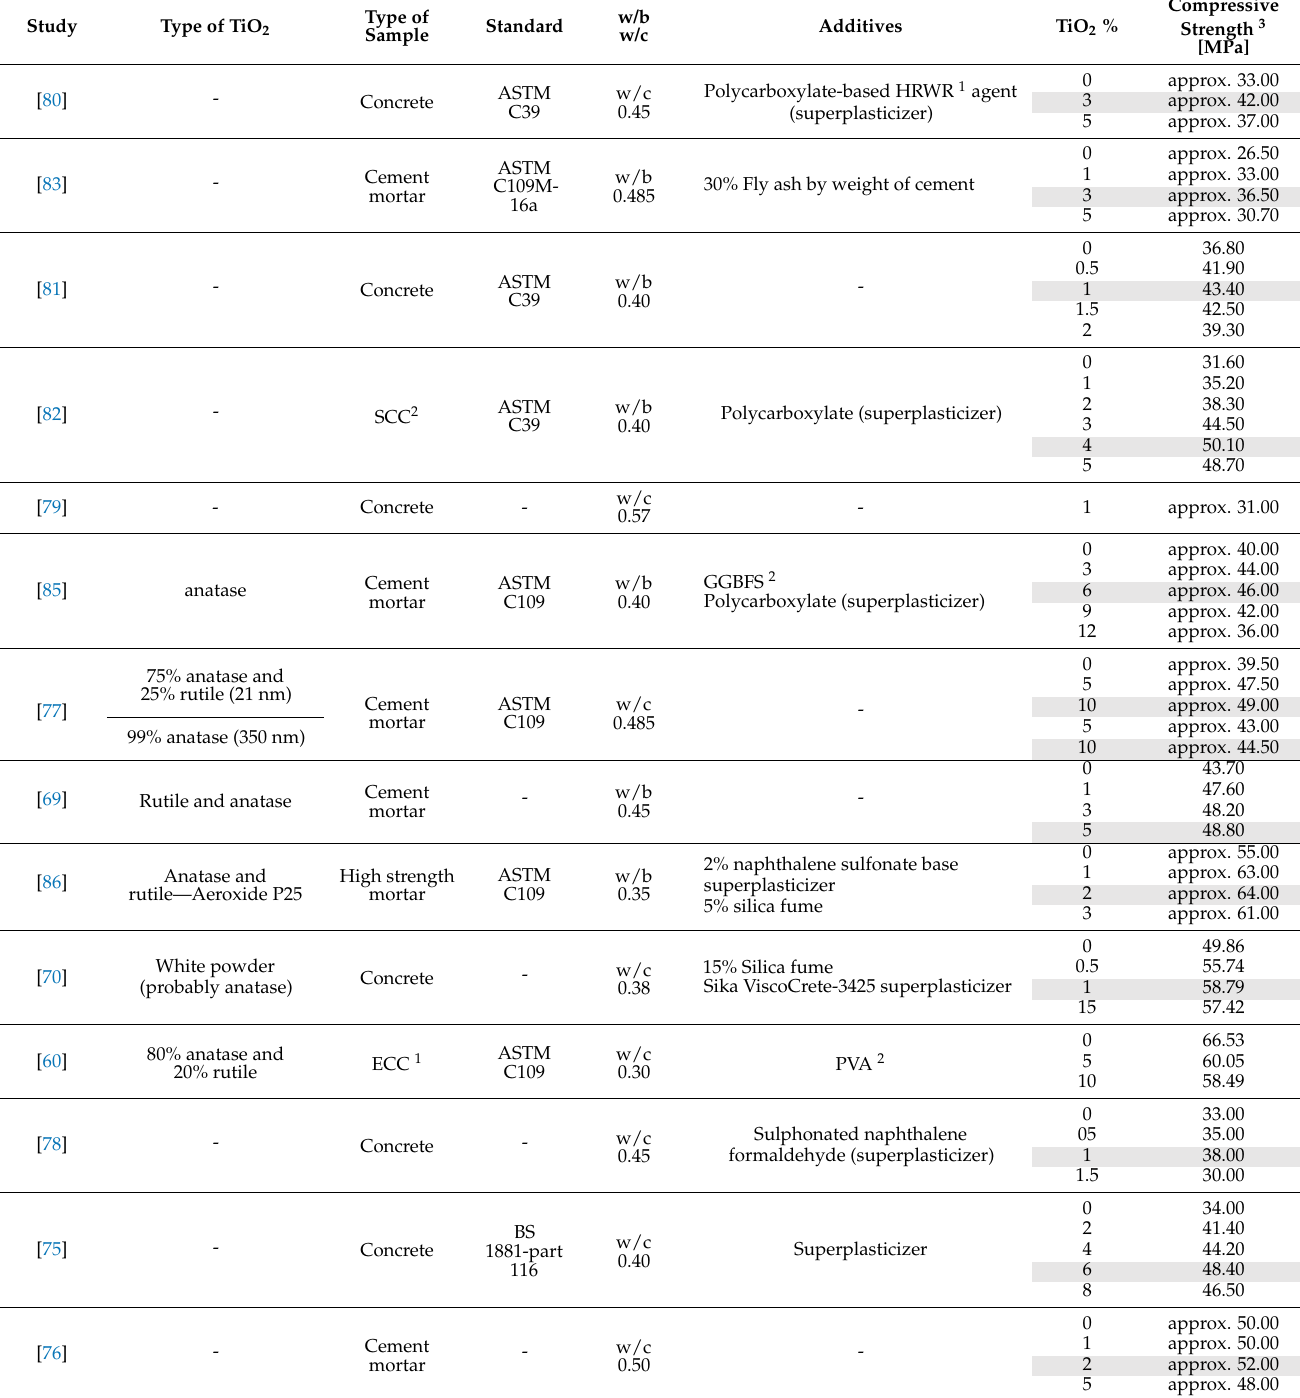
Table 8. Compressive strength values mortar/concrete specimens modified with TiO 2 nanoparticles, at room